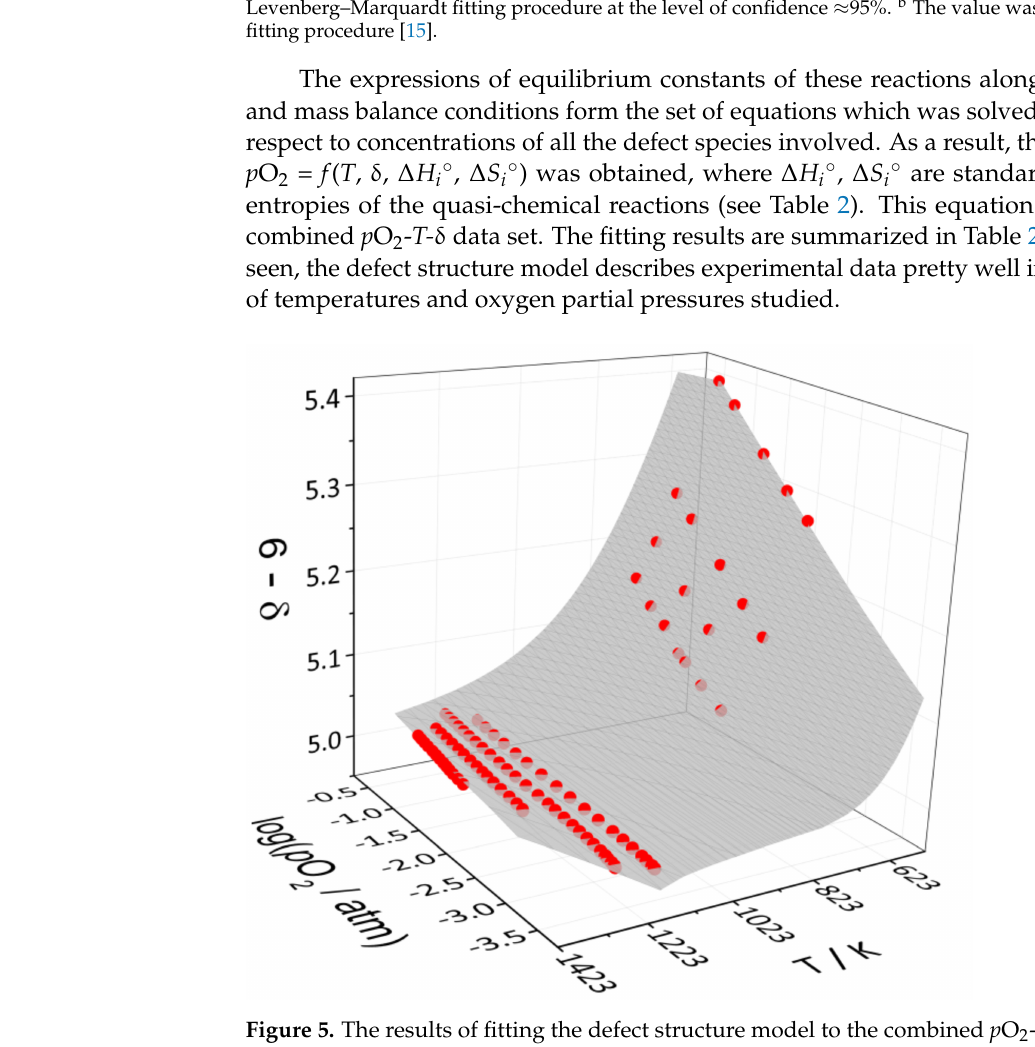
Figure 5. The results of fitting the defect structure model to the combined p O 2 - T- δ -dataset of YBC: the spheres correspond to the experimental values obtained in this (573–773 K) and the previous work [30] (1173–1373 K); the surface represents the model